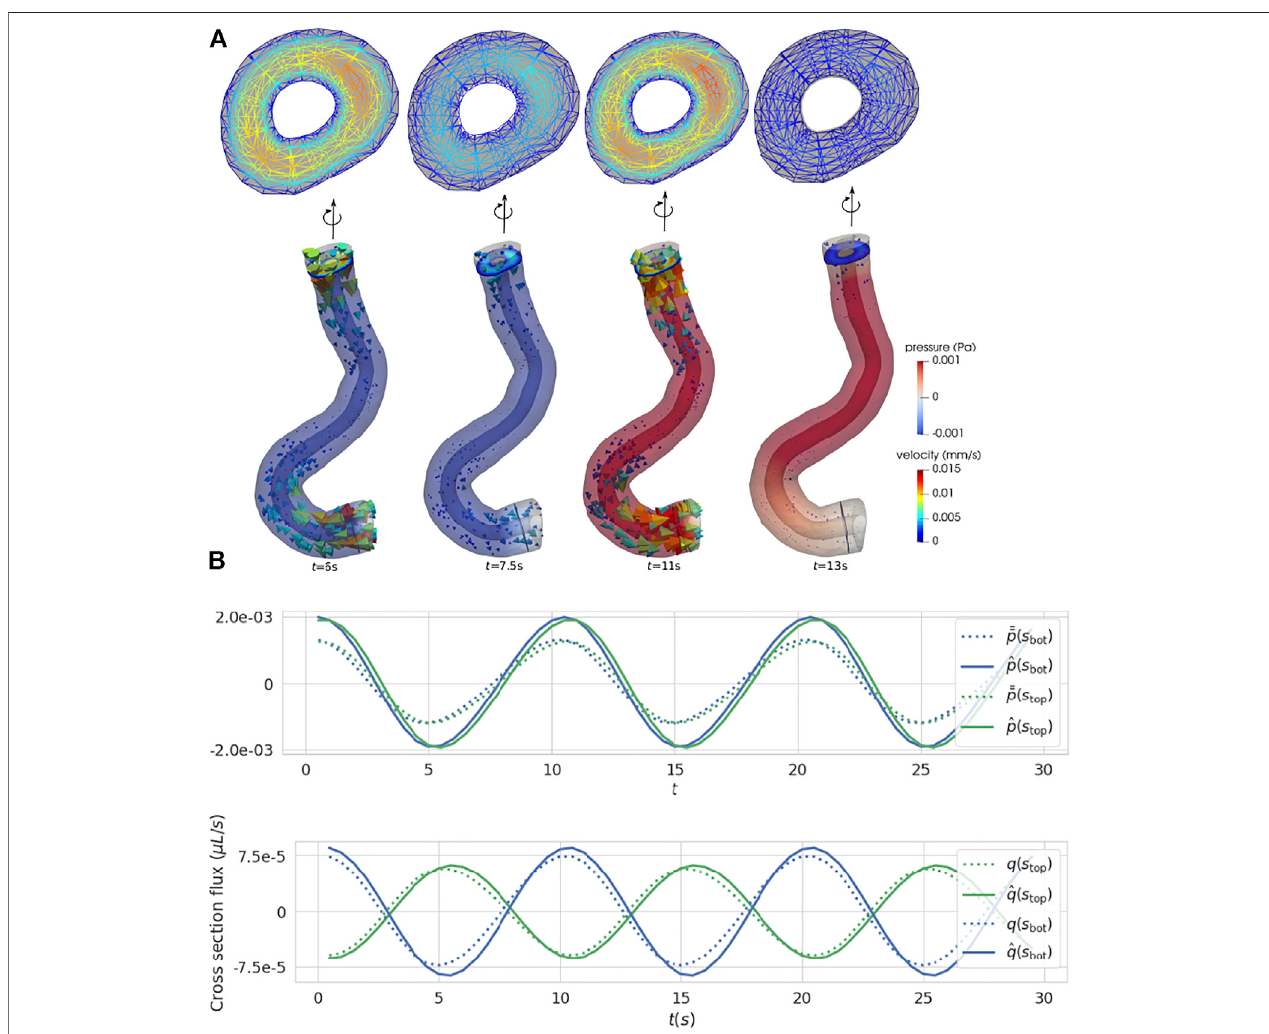
FIGURE 5 | Vasomotion induces higher domain deformations but lower wall velocities, pressure differences and cross-section fl uxes. (A) Snapshots of the full model pressure and velocity at different time points with cross-section velocities (top). (B) Average pressure (upper panel) and fl ux (lower panel) for the full and reduced models at upper and lower cross-sections over time. The values at the different cross-sections are slightly shifted in time due to the travelling vasomotion. The pressure model discrepancy dominates the fl ux differences.